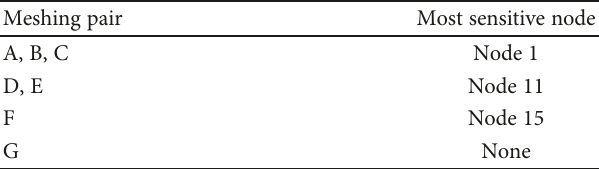
Table 3: Sensitivity correspondence of shaft length. Meshing